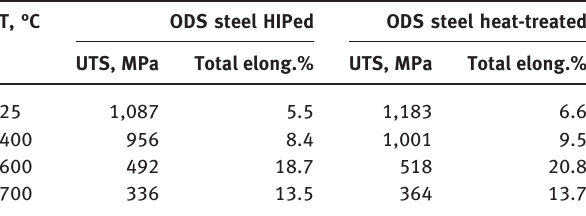
Table 1: High-temperature tensile testing of the HIPped and heat- treated ODS steel. T, °C ODS steel HIPed ODS steel